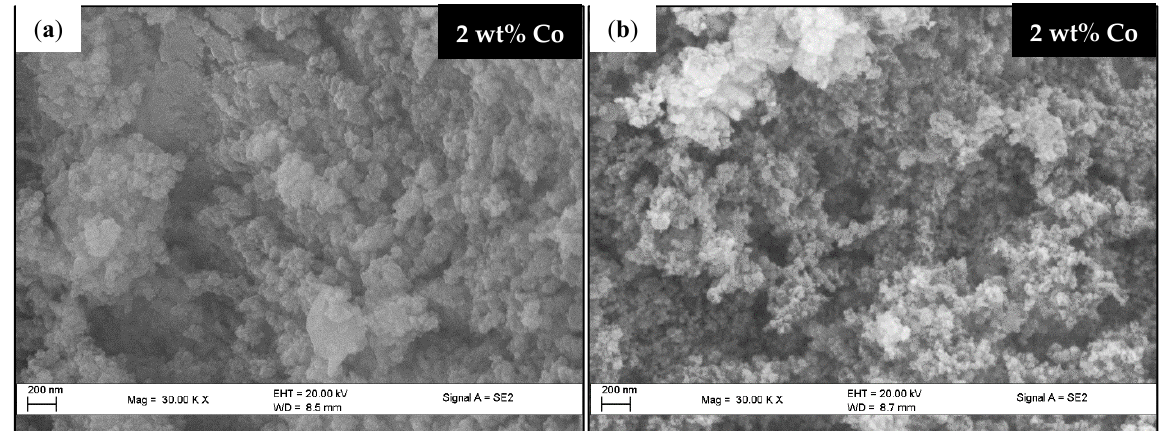
Figure 17. SEM micrographs of 2 wt% Co catalysts; ( a ) fresh catalyst, ( b ) used catalyst.